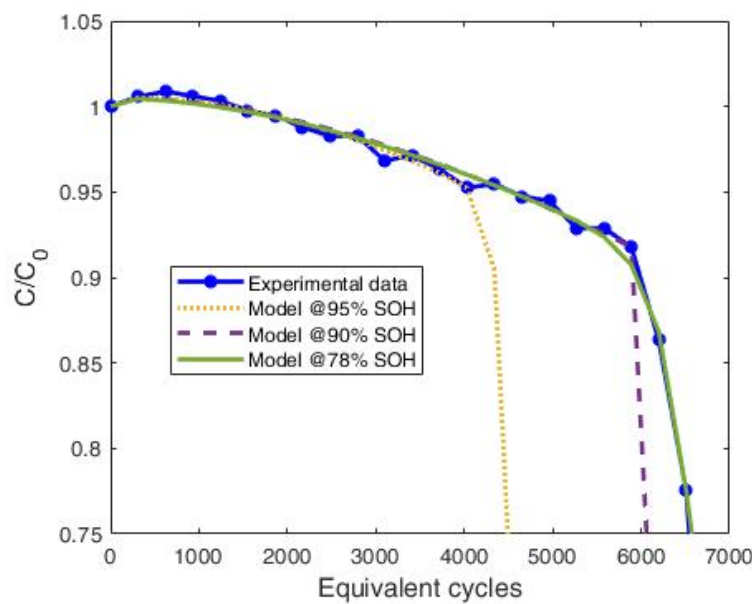
Figure 12. Comparison among model (8) outputs for the parameters evaluated at a different SOH. When the model parameters are evaluated using all the experimental data, until EOL, the modified Markov model is able to reproduce the curve, as expected. However, when the parameters are evaluated at 95% SOH, the error on the estimated and actual EOL number of equivalent cycles is around 44%, while, for 90% SOH, it is around 8%. In both cases, errors are larger than what obtained with the extrapolation approach. 4. Conclusions The present study determines the effects that some stress factors, such as the depth of discharge and discharge current, have on the cycle life of lithium-ion batteries. To this end, life tests were conducted on battery cells. In particular, the cells under consideration use a technology based on lithium nickel cobalt manganese oxide (NCM) at the positive electrode and graphite at the negative electrode. Since the anode and cathode composi- tions are fundamental in the determination of the degradation process of lithium-ion cells, the results obtained during the study are strictly valid only for the analyzed technology. The results obtained are, in any case, in line with what is known in scientific literature, i.e., a faster degradation of batteries subjected to high discharge currents and greater depths of discharge. We set up an experimental matrix to evaluate the impact of different stresses on the capacity fade. The data were used to study a methodology that would allow a reasonable life estimation even with a limited number of data available. We focused on a model that refers to the Markovian process structure, although it is not Markovian since the proba- bility transition is dependent on the system history. This model describes the evolution of the system starting from an initial state consisting of different phases that evolves into successive states through a transition matrix. The three possible states are: dormant, in which the potential charge is found, but not directly available for cycling; active, in which the charge available for cycling is found; and dead, in which the charge is no longer avail- able. The latter is an absorber state of the system, that is, the fraction of the system that reaches this state cannot pass into any other state. This model showed a good degree of fitting for the degradation curves of the analyzed cells, also managing to capture the knee present in some experimental results. As regards the ability to predict the trend of the